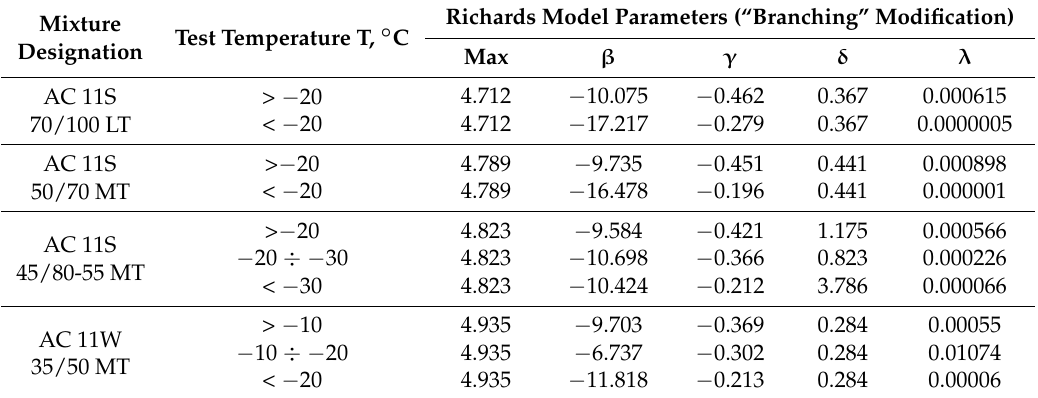
Table 6. Master curve parameters for the Tensile Creep Test